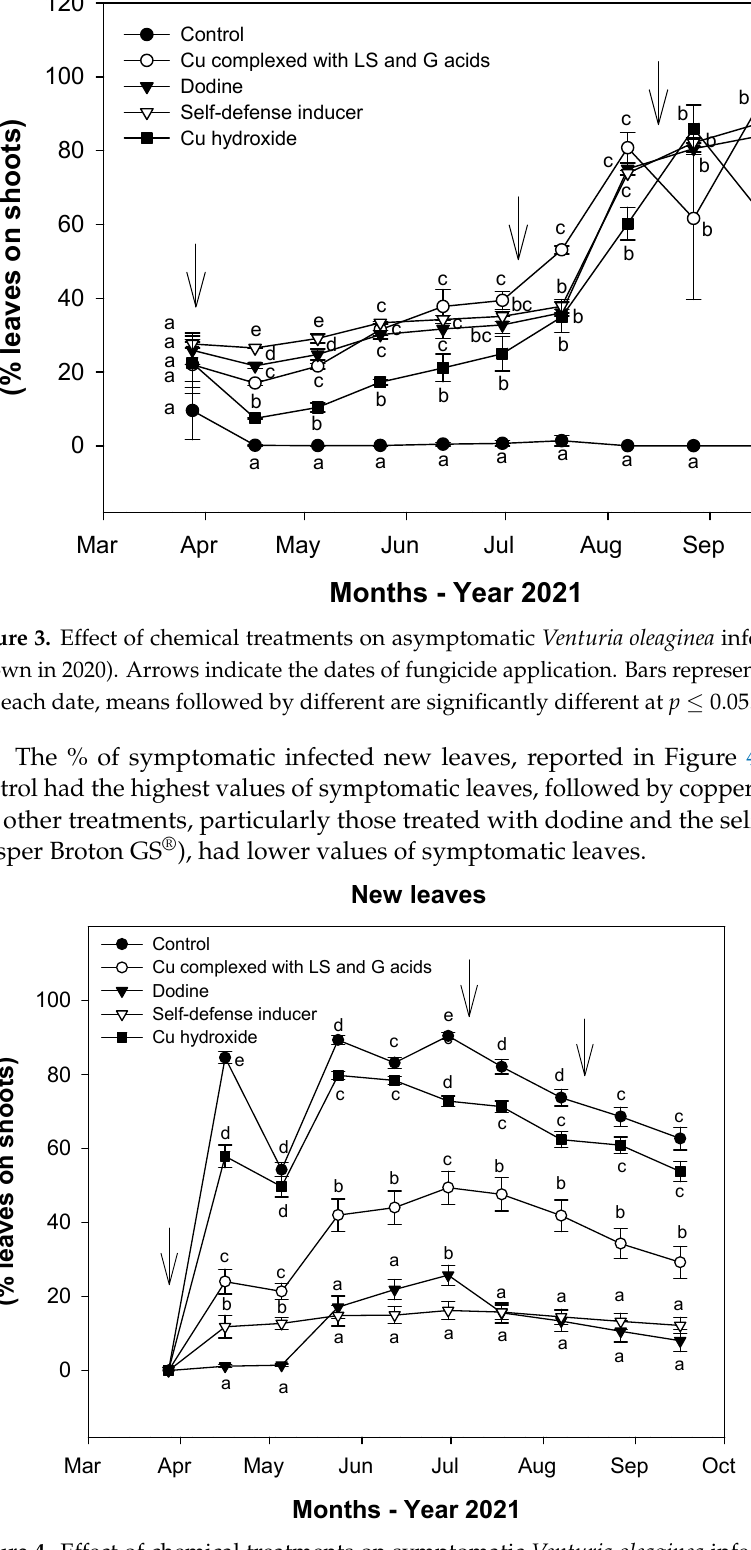
aabc c Figure 5. Effect of chemical treatments on asymptomatic Venturia oleaginea infection in new leaves (grown in 2021). The arrows indicate the dates of fungicide application. The bars represent the standard error. For each date, means followed by different are significantly different at p ≤ 0.05.